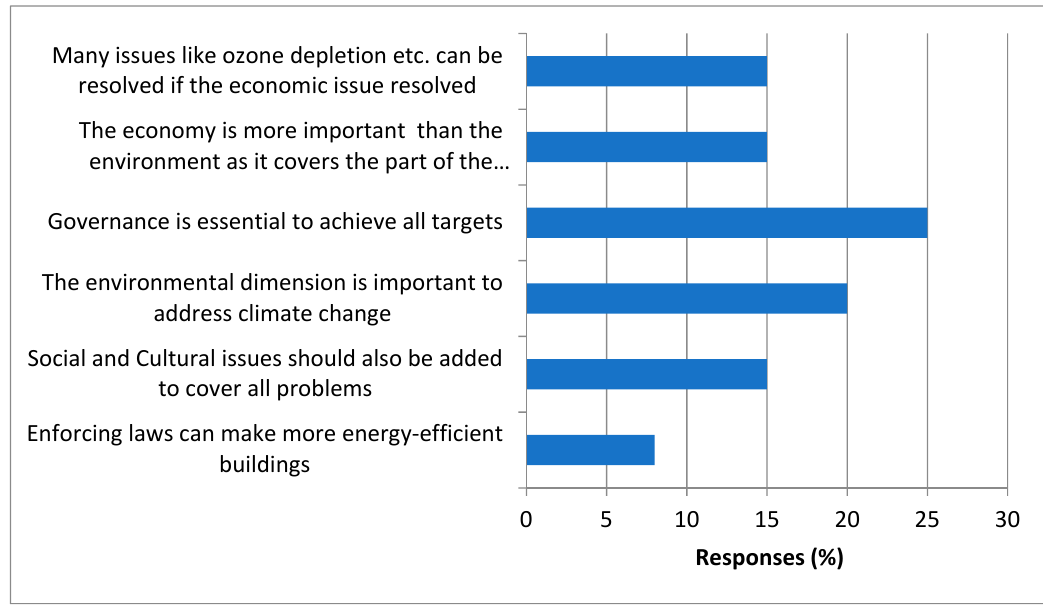
Figure 4. Summary of importance of all the dimensions in the rating tool to move towards sustainable development recorded in the interviews.